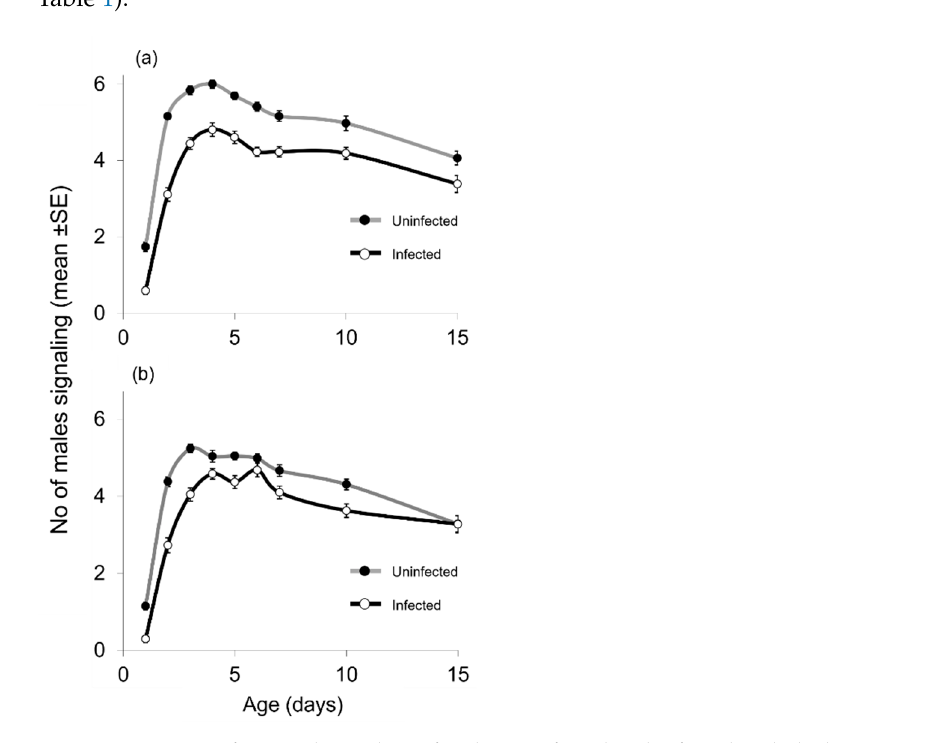
Figure 1. Age-specific sexual signaling of males uninfected and infected with the bacterium Wolbachia fed on ( a ) yeast plus sugar and ( b ) sugar only. On each day of age, observations were conducted hourly from 07:00 to 21:00 h in 10 cages (replicates) containing 10 males each. Values on the y -axis are mean numbers (±SE) of males signaling per cage per hour observation. Table 1. Repeated measures analysis of variance on the effect of infection (first factor), food (second factor), and age (repeated factor) on Ceratitis capitata male sexual signaling. Ages from adult day 1 to adult day 15 were considered in the